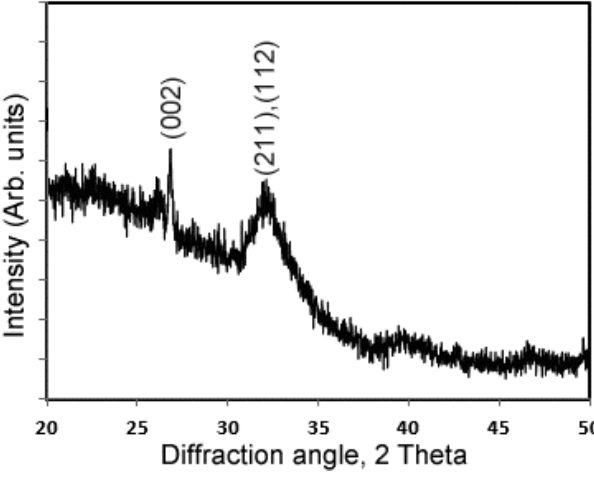
Figure 4. XRD profile of minerals formed in the presence of EHBP shows diffraction peaks at 2 θ = 25.9° and 32.9° corresponding to the {002} and the {211}/{112} planes of hydroxyapatite.